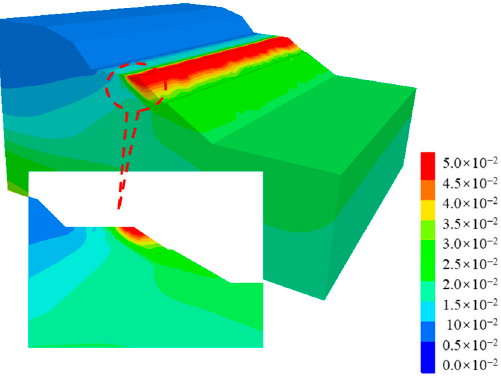
Figure 10. Displacement contour of the cut-and-fill subgrade after earthquake.